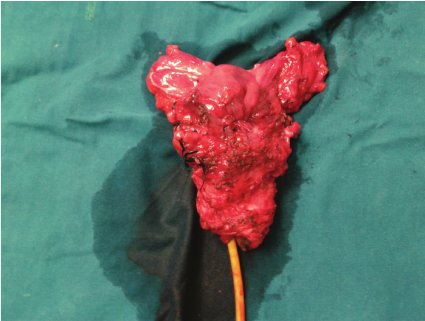
Figure 1: Specimen of radical cystourethrectomy + total vaginec- tomy.